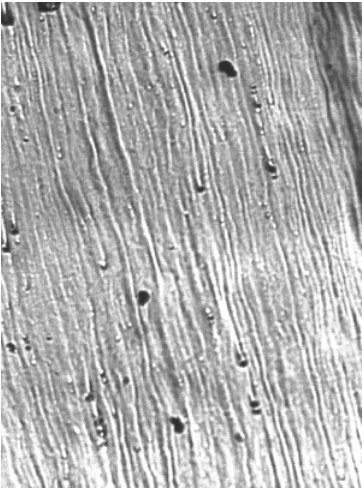
FIG. 2. Optical image of a surface. The vertical size of the image is 500 m m, and the horizontal size is 370 m m. with the z axis directed along the tube axis and the x axis locally directed along the azimuthal coordinate u in the cylindrical coordinate system associated with the tube. We note that, due to the assumed smallness of the surface features, we can use the local Cartesian coordinate system x , y , and z in Eqs. (7) and (8) instead of the global cylindrical coordinate system u , r , and z